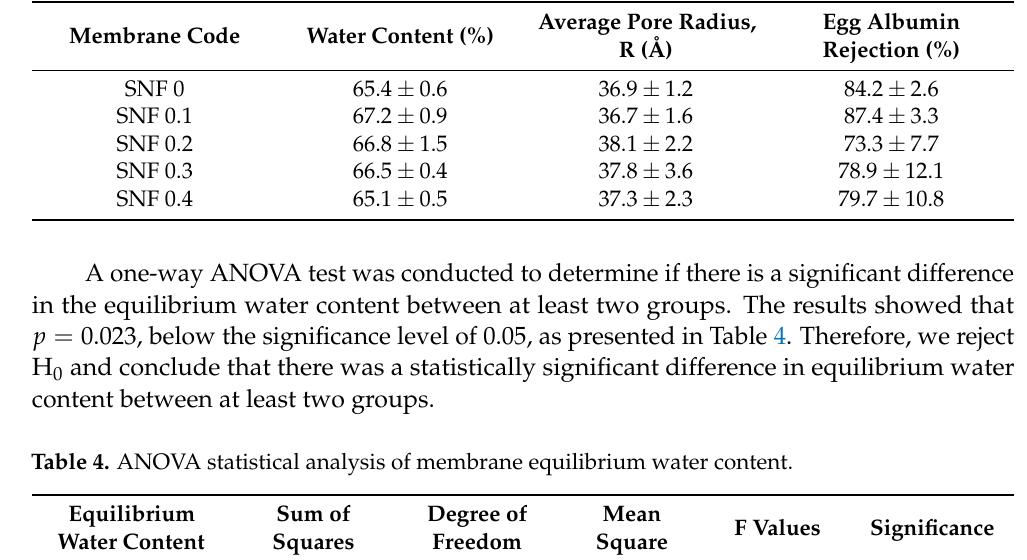
Figure 5. Equilibrium water content of the fabricated membranes at different SNF concentrations. Table 3. Performance of PSF/SNF membranes.